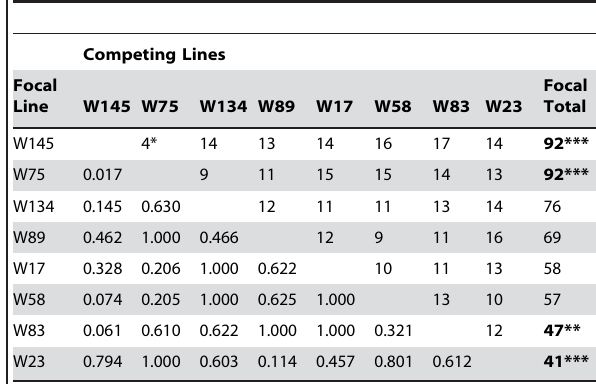
Table 1. Territorial success scores for paired combinations of Winters inbred lines of D. melanogaster